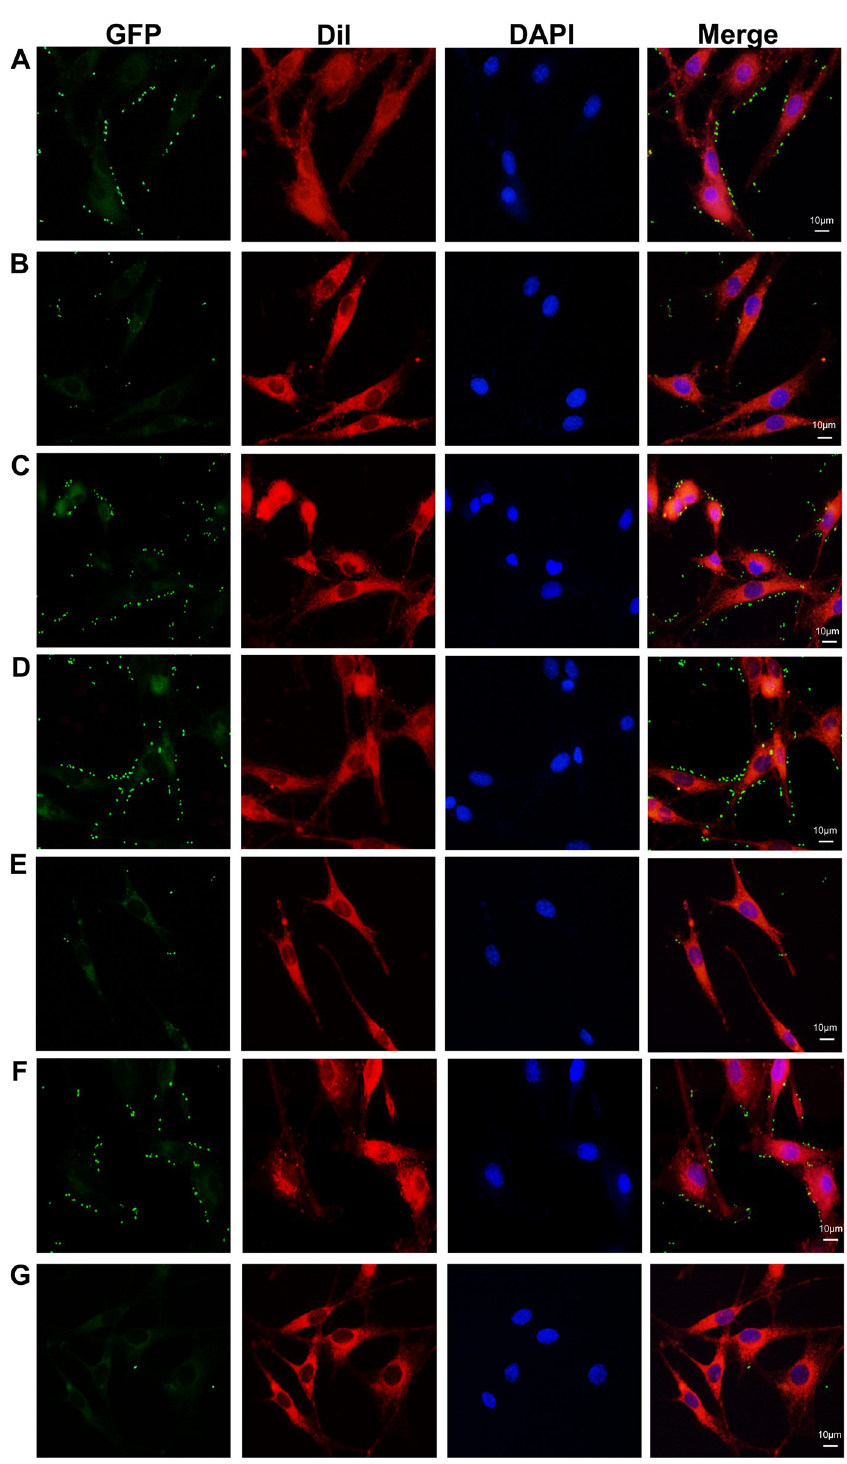
Fig 5. Surface display assays. Adhesion and inhibition of E . coli BL21 (DE3) containing pIGN-PDHA or pIGN-PDHB to DF-1 cells. Adhesion of E . coli BL21 (DE3) containing pIGN-PDHA (A) or pIGN-PDHB (D) to DF-1 cells. Adhesion of E . coli BL21 (DE3) containing pIGN-PDHA to DF-1 cells inhibited by mouse anti-rPDHA (B) but not non-immunized mouse serum (C). Adhesion of E . coli BL21 (DE3) containing pIGN-PDHB to DF-1 cells inhibited by mouse anti-rPDHB (E) but not non-immunized mouse serum (F). PIGN (G) was used as the negative